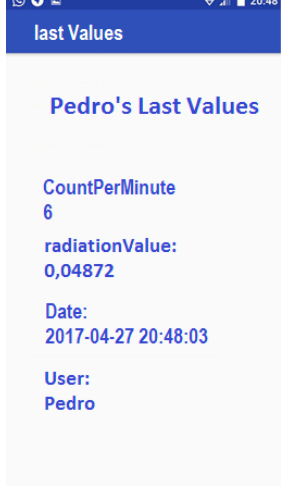
Figure 19. Last values screen shot.